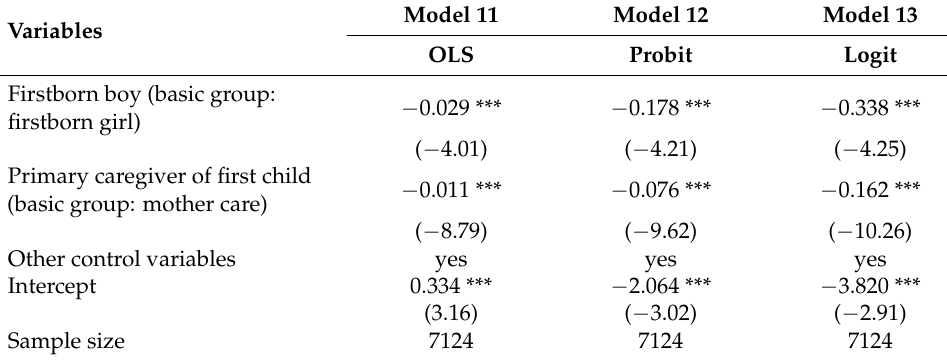
Table 5. Effect of a firstborn boy on the pregnancy of migrant women.